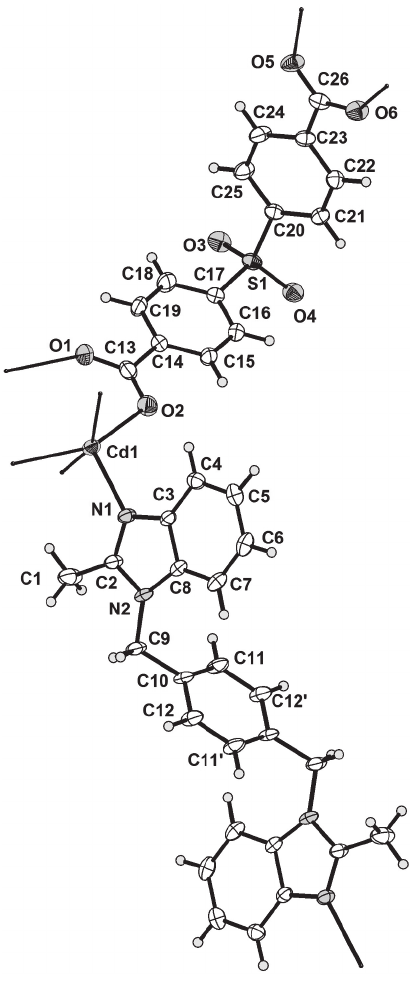
Figure 1: Coordination environment of Cd(II) ion in the title